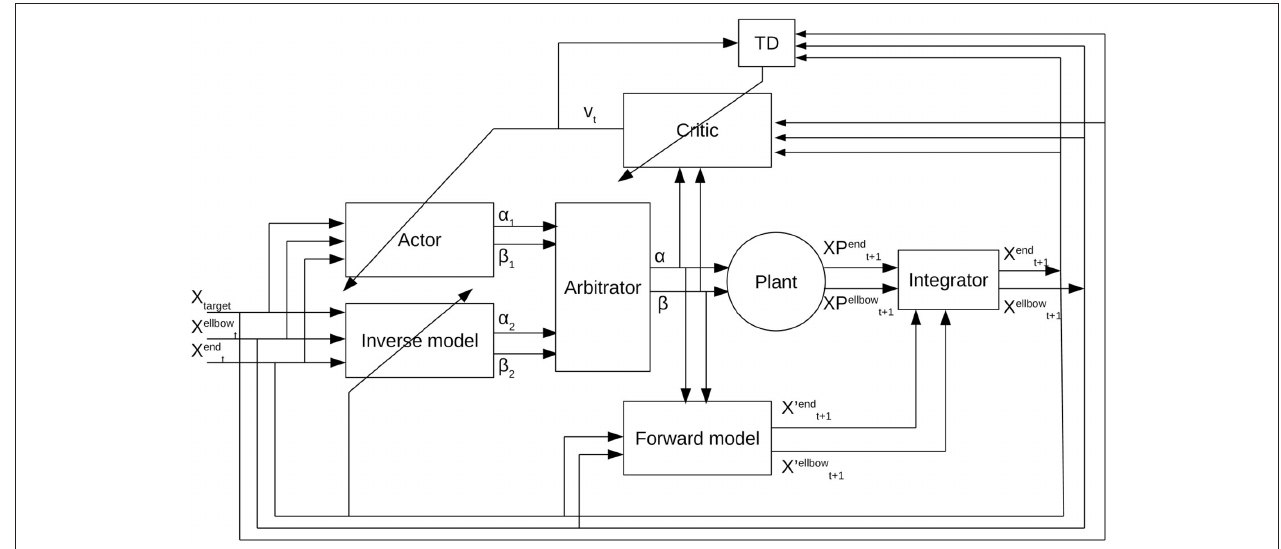
FIGURE 3 | Arbitrated predictive actor critic: The actor receives the current state defined as the current location of the robot arm and the target location, and provides an action that is the change in angles for shoulder and elbow. The inverse model takes the current state and predicts another action. The output of the inverse model and the actor goes to the arbitrator. Then the arbitrator selects one of these actions. The output of the arbitrator along with the current state is the input to the critic from which the critic predicts a reward. The forward model receives the selected action and the current position of the agent and predicts the future state of the agent. The agent takes the selected actions and transfers to the next state. The predicted future state from the forward model is integrated with the estimation of the actual state of the plant after taking the action and obtains a new current state for the